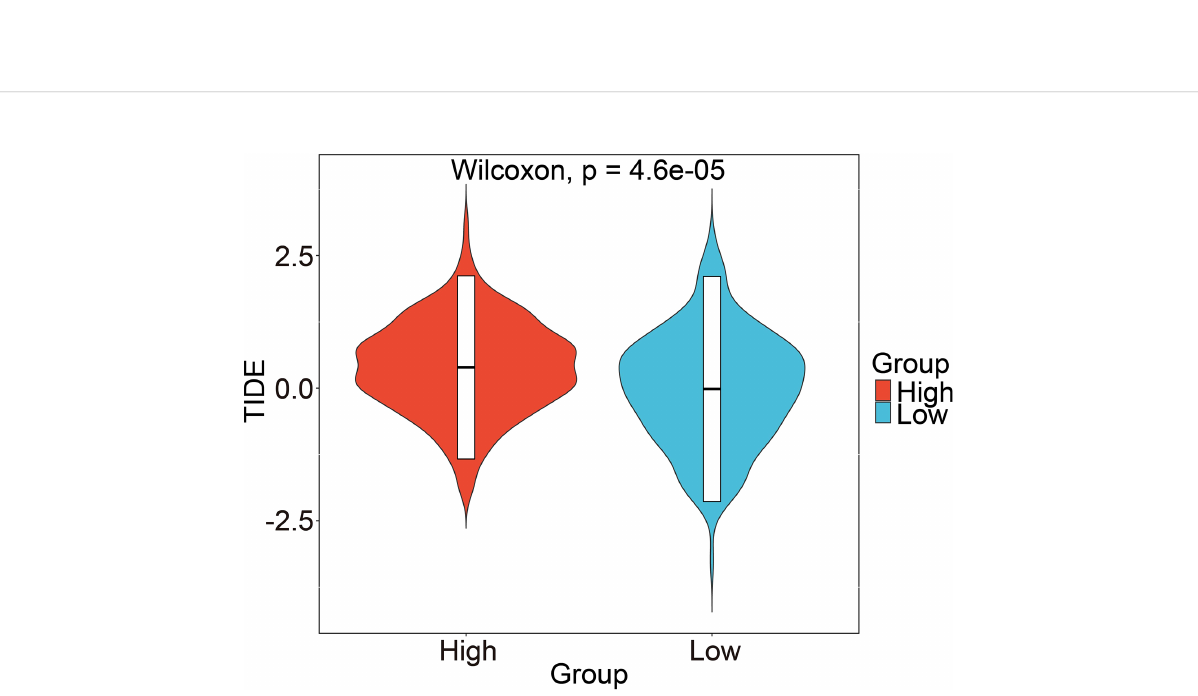
FIGURE 10 Prediction of risk score-related immune responses of immunotherapy. Prediction of risk score-related immune responses of immunotherapy. Distribution of risk score in TIDE scores by TIDE